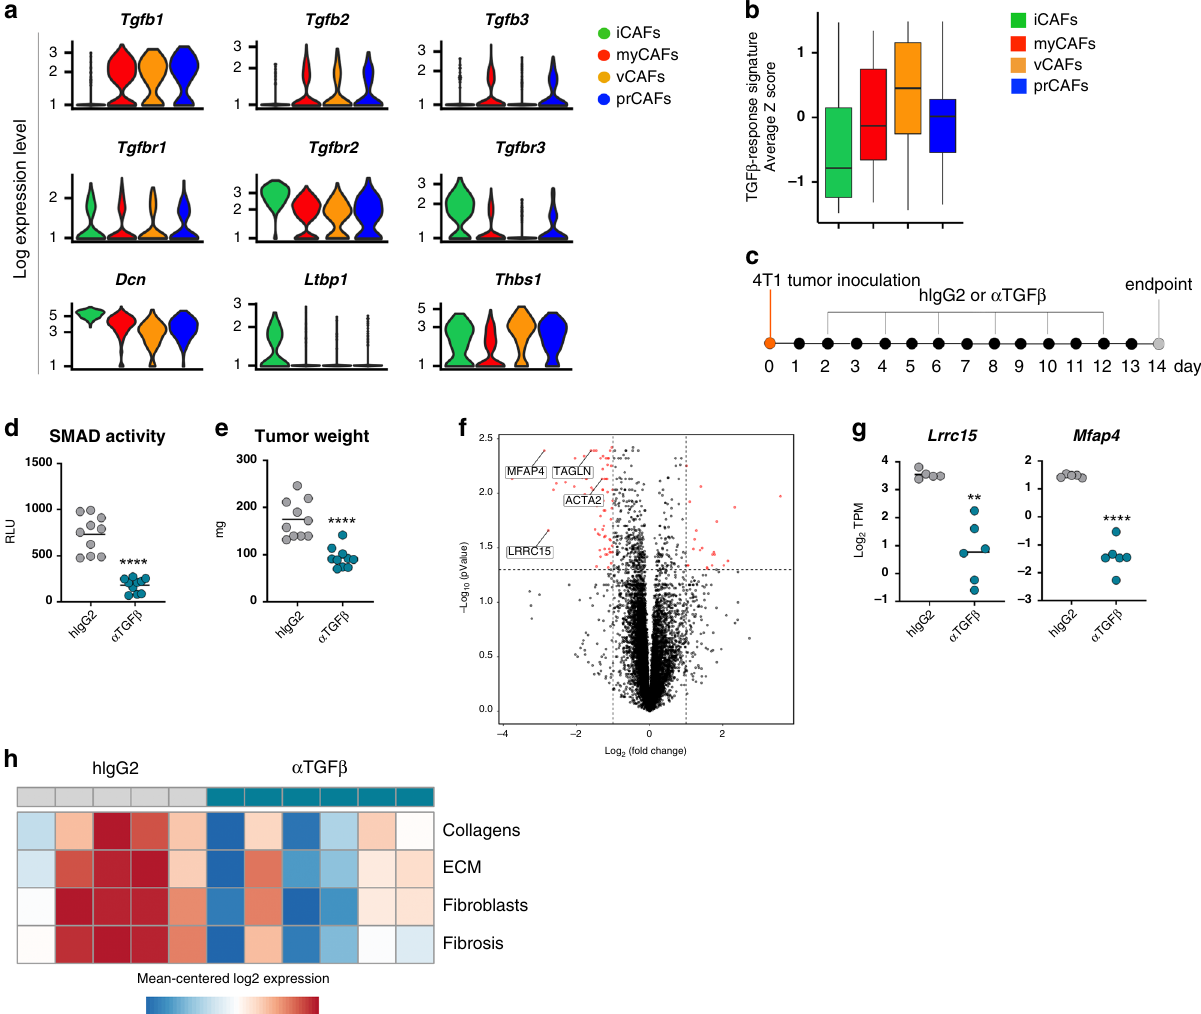
Fig. 2 TGF β -neutralization modulates CAF function in the TME. a Violin plots of genes encoding ligands, receptors, and modulators of TGF β signaling in CAF subsets from 4T1 tumors, as analyzed by single cell RNAseq. n = 5 samples from 3 independent experiments. b Box plots depicting alignment of subset gene expression to TGF β responsiveness signature, described previously 52 . The bounds of the boxes indicate the 25 th and 75 th percentiles, the center band re fl ects the median, the lower whisker indicates the minimum, and the upper indicates the maximum. c Study schematic of TGF β -blockade in vivo. d Cell based SMAD-reporter assay con fi rming systemic inhibition of TGF β activity in mice receiving TGF β -neutralizing antibodies. Each dot represents a mouse. Mean is depicted. n = 10 mice. Data are representative of three independent experiments. **** p < 0.0001 (unpaired, two-tailed t -test with Welch ’ s correction). e Tumor weights at endpoint. Each dot represents a mouse. Mean is depicted. n = 10 mice per group. Data are representative of three independent experiments. **** p < 0.0001 (unpaired, two-tailed t -test with Welch ’ s correction). f Tumors as in c were pulverized and RNA was extracted for RNAseq analysis. Volcano plot of bulk RNAseq data depicting changes in gene expression between treatments; horizontal dashed line indicates an adjusted p -value of 0.05, vertical dashed lines indicate an absolute log2 fold change of 1 ( p -values were calculated based on a t -statistic for coef fi cients from a linear model fi t to the data). g Comparison of log2 TPM from bulk RNAseq data for selected genes in isotype- and anti-TGF β -treated mice. Each dot represents a mouse. Mean is depicted. n = 5 (hIgG2) or 6 ( α TGF β ) mice per group. Data are representative of two independent experiments. ** p = 0.0013; **** p < 0.0001 (unpaired, two-tailed t -test with Welch ’ s correction). h Heatmap of stroma-associated signatures in bulk RNAseq data. Values were TPM normalized, log2 transformed, and row mean centered ( z -score). Each column represents a